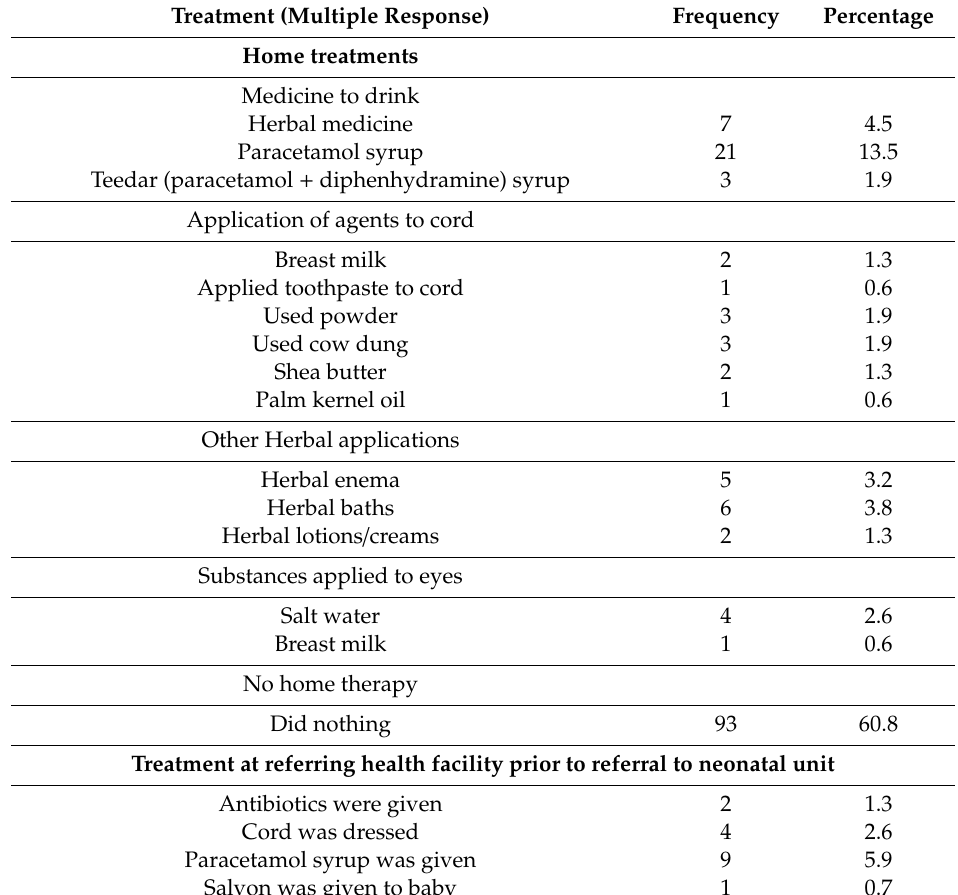
Table 3. Treatments received by outborn infants prior to reaching referral hospital.